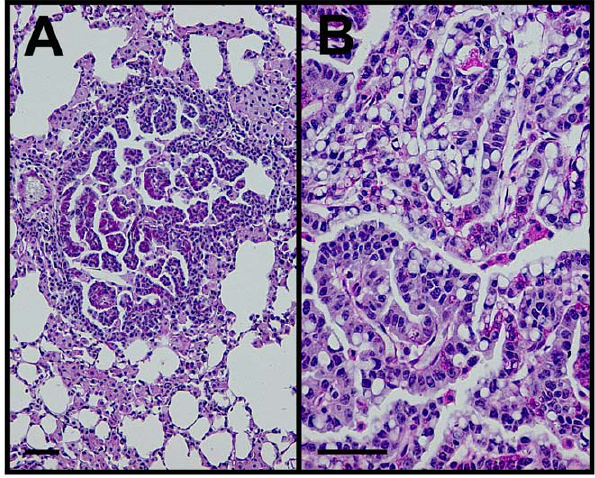
Figure 4. Kras G12D mutation led to adenoma formation in lungs. A, B. PAS and hematoxylin staining of lung adenomas typical of CK19 CreERT ; LSL-Kras G12D mice. Size bars, 50 m m.